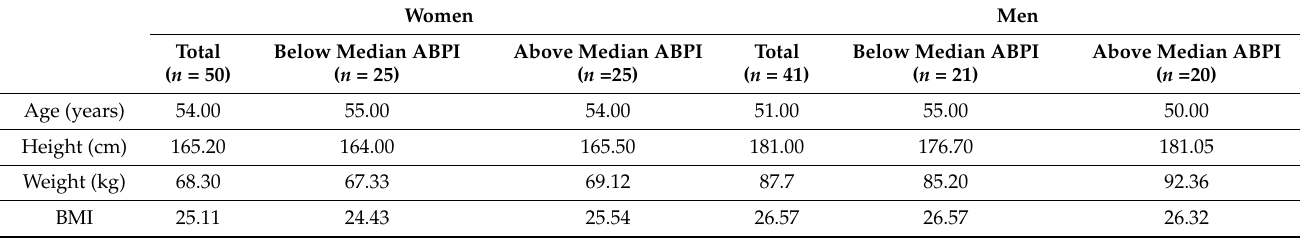
Table 1. Self-reported age and anthropometrics for 41 men and 50